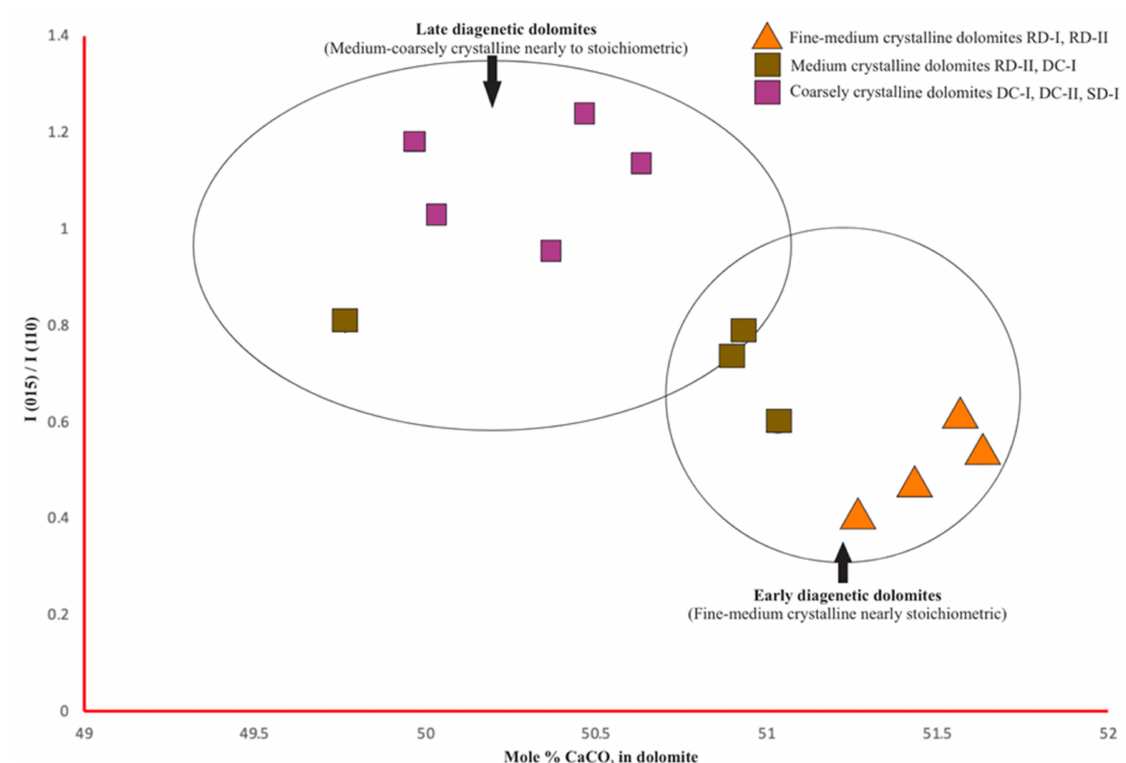
Figure 9. Diagram showing degree of order versus stoichiometry of the different types of dolomites in Kingriali Formation (“I” indicates the integral intensity of XRD peaks observed during interpreting results by Lumsden’s